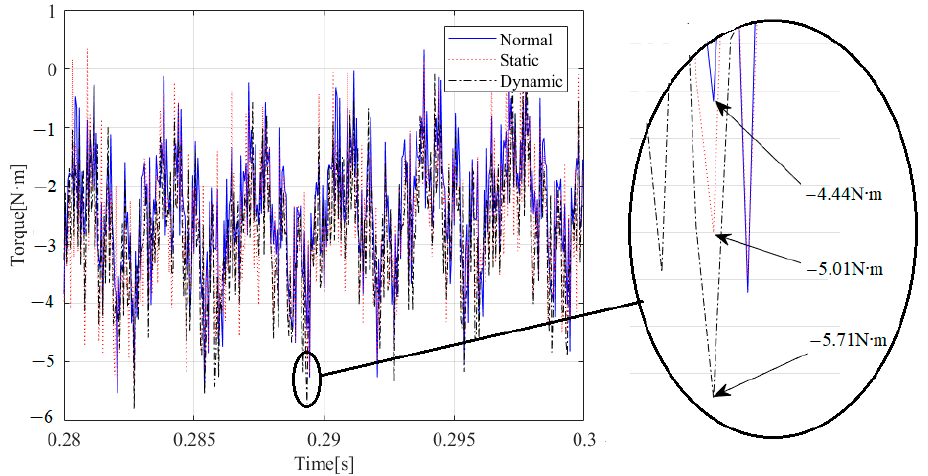
Figure 6. Comparison of no-load torque under three operating conditions.